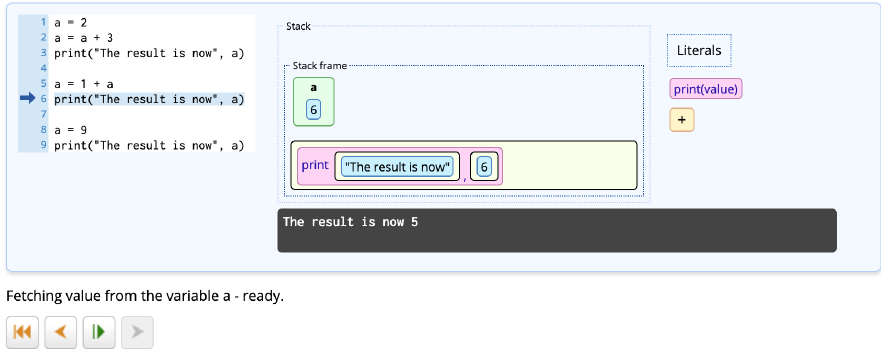
Figure 4. An example of program visualization (animated example) that is hosted by ACOS server. The visualization shows the stack state and the console output based on the current execution step.